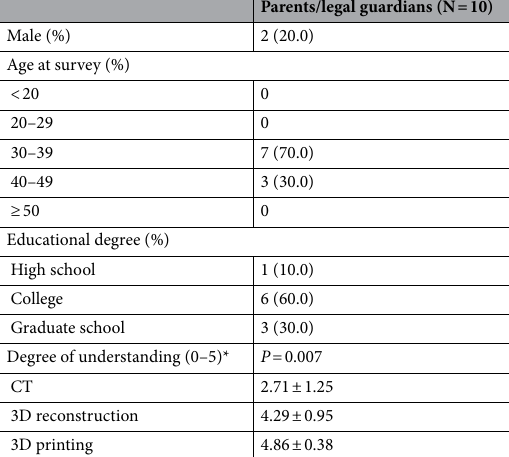
Table 7. Demographics and survey results on parents/legal guardians. CT, computed tomography. *Scale: 0 (poor) to 5